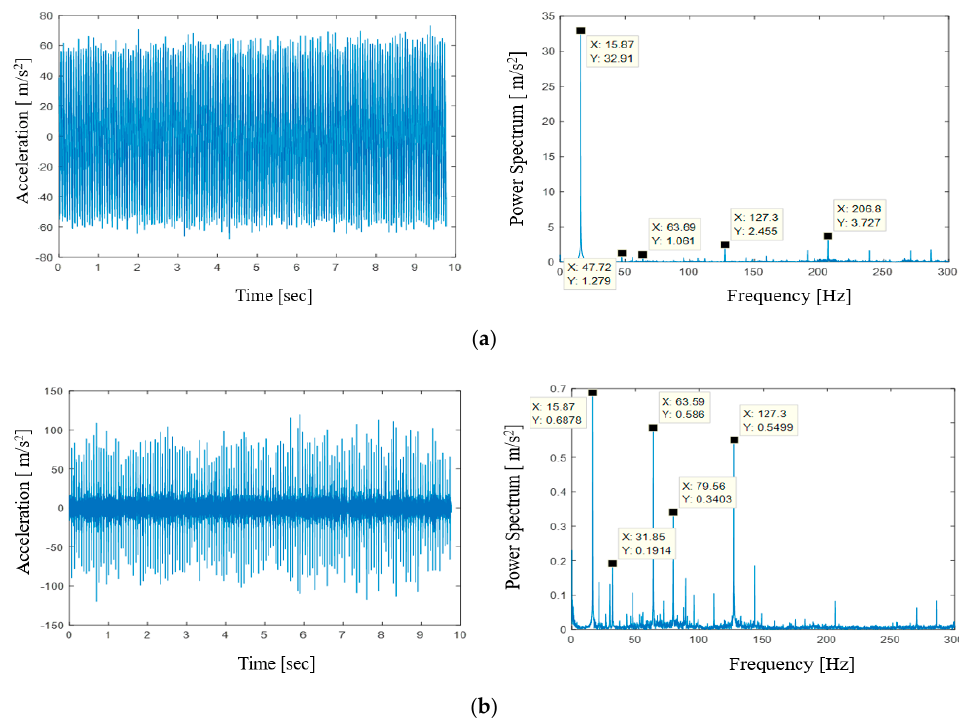
Figure 7. Vibration responses during multiple operations of entire facilities; ( a ) Vibration response at the top point of the coil spring in the screen unit; ( b ) Vibration response at the bottom point of the coil spring in the screen unit.